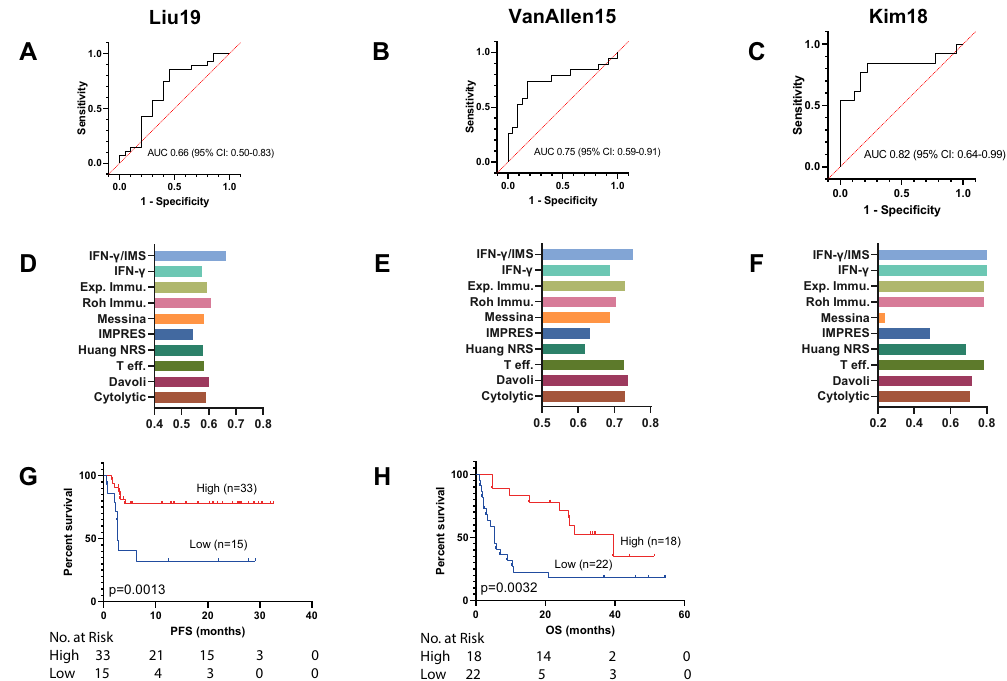
Fig. 6 Ratio of IFN- γ signature to IMS predicts response to ICI immunotherapy on published datasets. A – C ROC curve of the sensitivity versus 1-speci fi city of the predictive performance of IFN- γ /IMS. Patients with SD were not included in AUC calculation. D – F Comparison of the AUC of IFN- γ /IMS with nine GEP signatures (Table 1) in predicting response to ICI. G , H Kaplan – Meier plots of OS segregated by IFN- γ /IMS ratio with cutoff values selected according to the Youden index identi fi ed in individual datasets. Kaplan – Meier plot for Kim19 was not generated due to unavailability of survival data for this